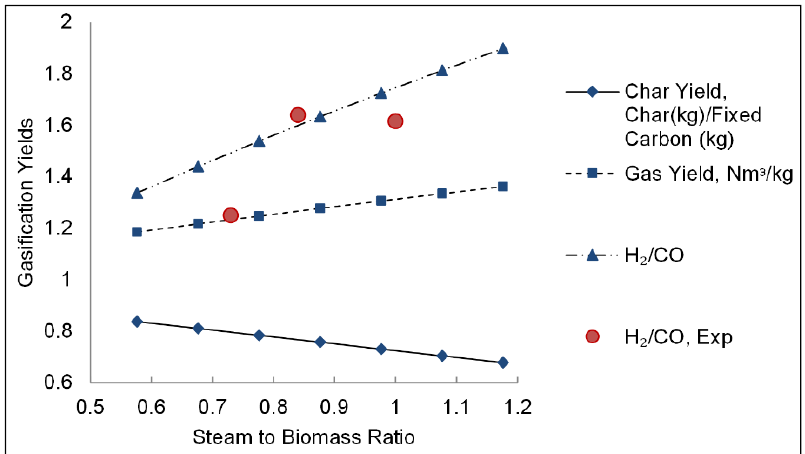
Figure 8. The effect of steam to biomass ratio on the system yields, T = 850